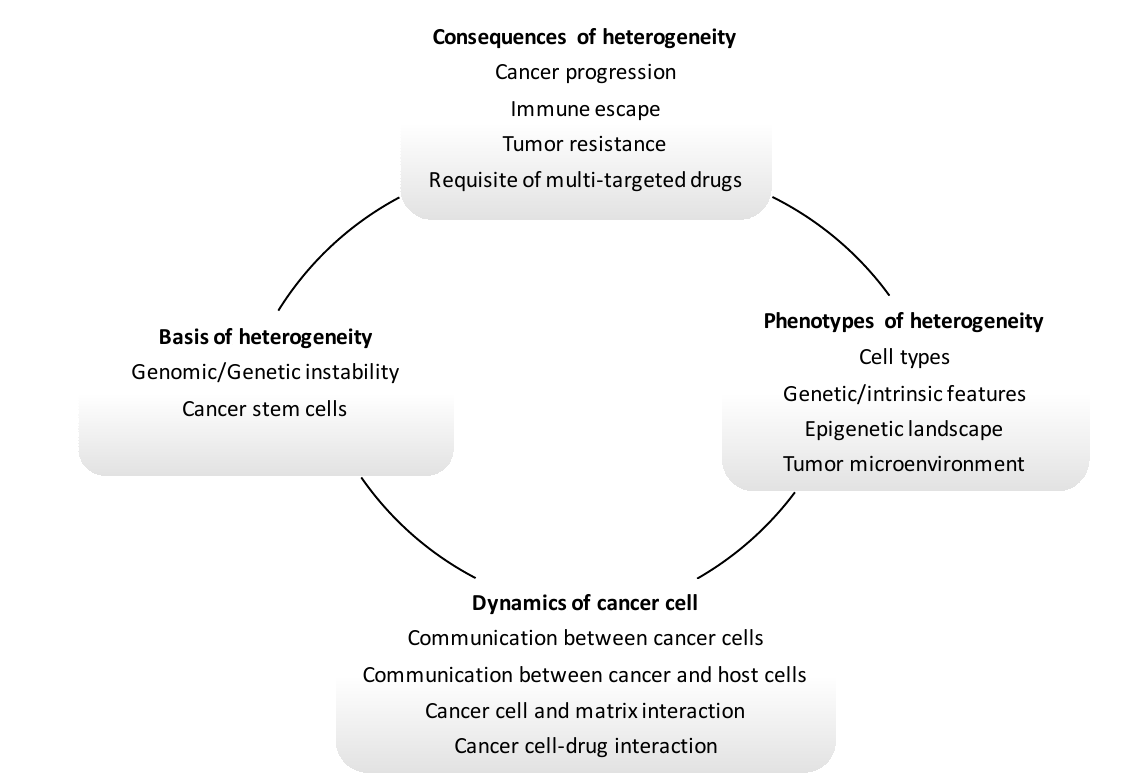
Figure 3. Principles of temporal and spatial heterogeneity of cancer.